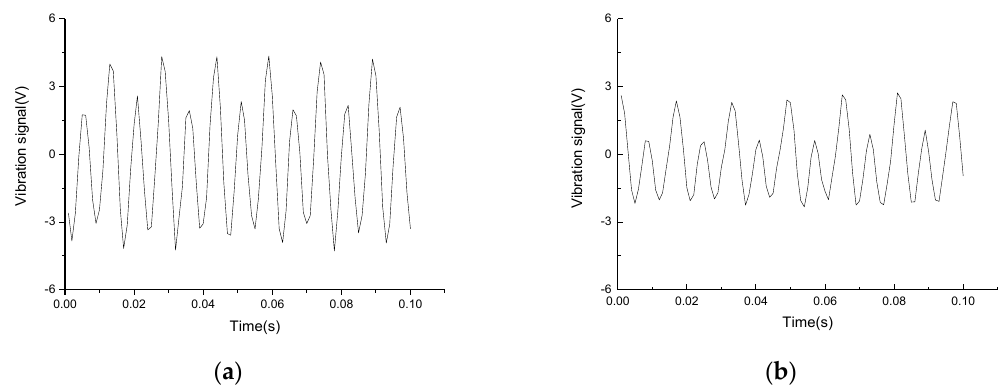
Figure 3. Vibration waveform of nozzle failure and normal condition. ( a ) Nozzle fault vibration waveform, ( b ) Normal vibration waveform .